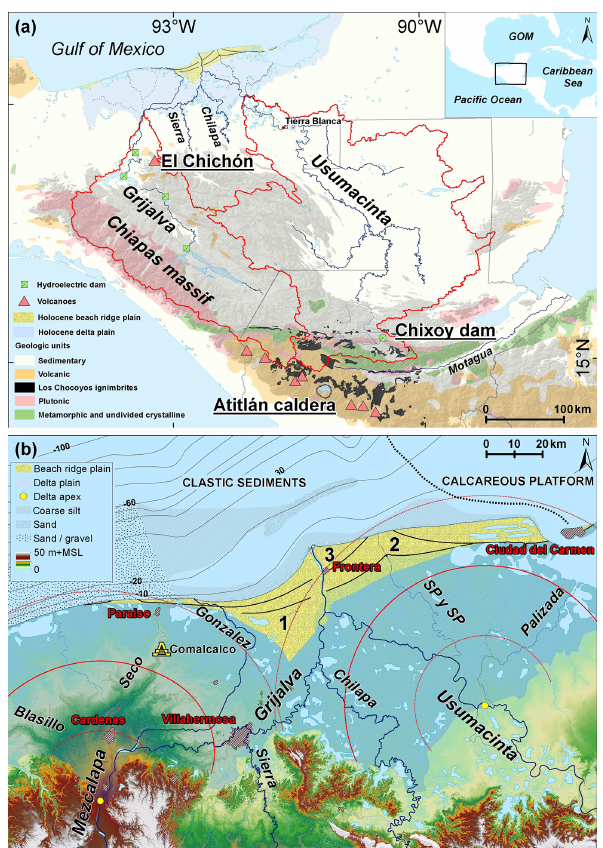
Figure 1. (a) Location of the Usumacinta–Grijalva beach-ridge sequence (yellow) along the edge of the Holocene delta plain (blue) and the drainage basins of the two main rivers travers- ing the headlands of this delta (red outlines). Simplified geolog- ical map modified from Garrity and Soller (2009) and extent of Los Chocoyos pyroclastic flow deposits adopted from the geolog- ical map of Guatemala at scale 1 : 500000 (Instituto Geográfico Nacional, 1970; Koch and McLean, 1975; Rose et al.,1987; and Sánchez-Núñez et al., 2015). Elevated uplands above 500ma . m . s . l . outlined using the SRTM 1arcsec dataset (USGS, 2009) are de- picted in grey. (b) Overview of the Usumacinta–Grijalva delta and the three main phases of Holocene beach-ridge formation defined by Psuty (1965, 1967). The apexes of the two main rivers (yellow dots) are indicated with 25, 50, and 75km equidistant lines (red lines). Nearshore distribution of coarse silty to gravelly surficial sediments after Ayala-Castañares and Guttiérrez-Estrada (1990). Surficial sed- iments from the remaining part of the continental shelf are com- posed of clay and fine